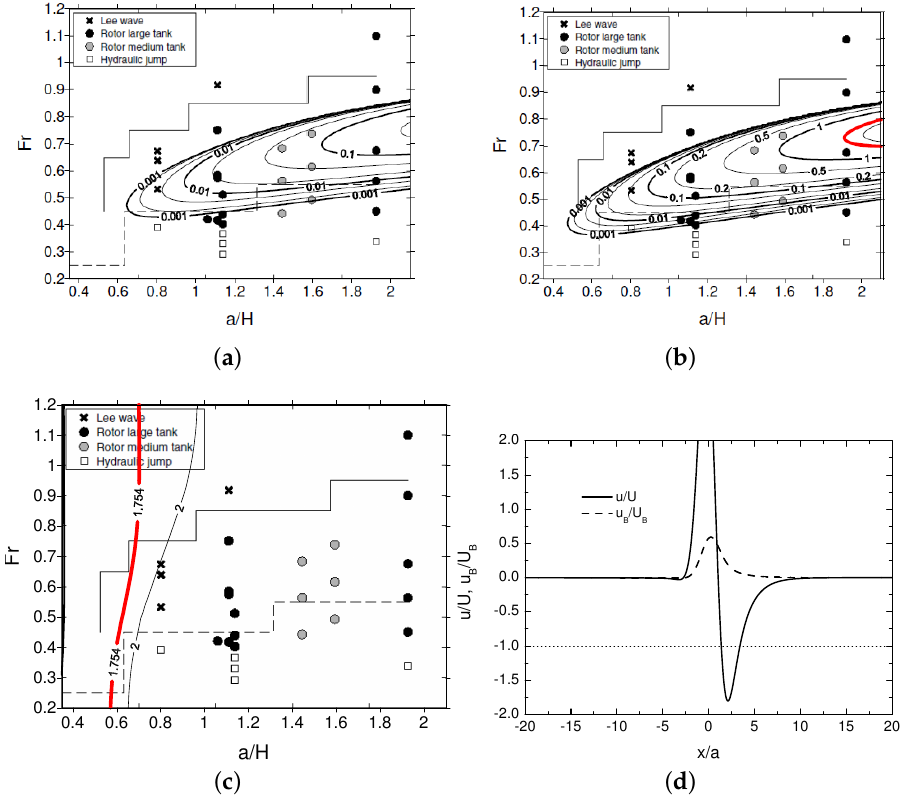
Figure 9. ( a – c ) Similar to Figure 8a–c, except that l 2 a = 2.278; ( d ) similar to Figure 8d, except that l 2 a = 2.278, Fr = 0.37, a / H =